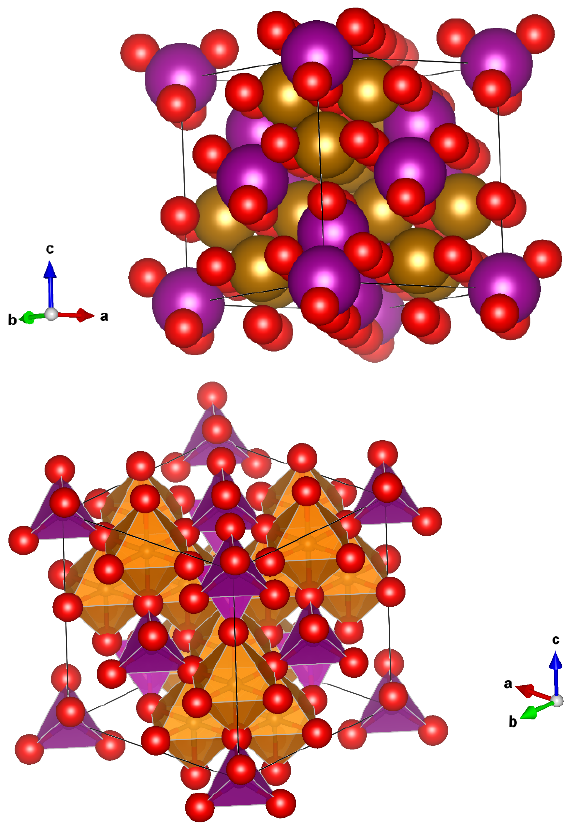
Figure 1: Crystal structure of Co x Cu 1-x Fe 2 O 4 .